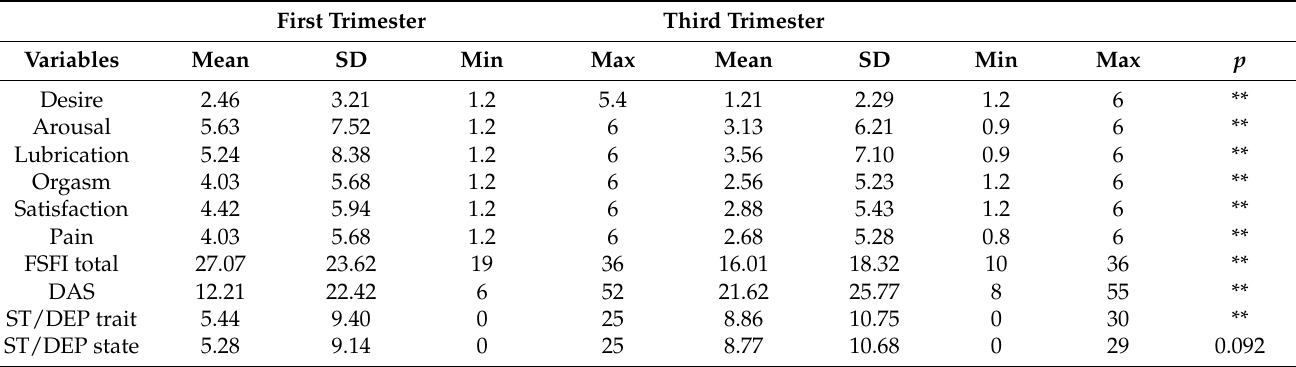
Table 2. Mean scores per questionnaire and comparison of differences ( n = 180). First Trimester Third